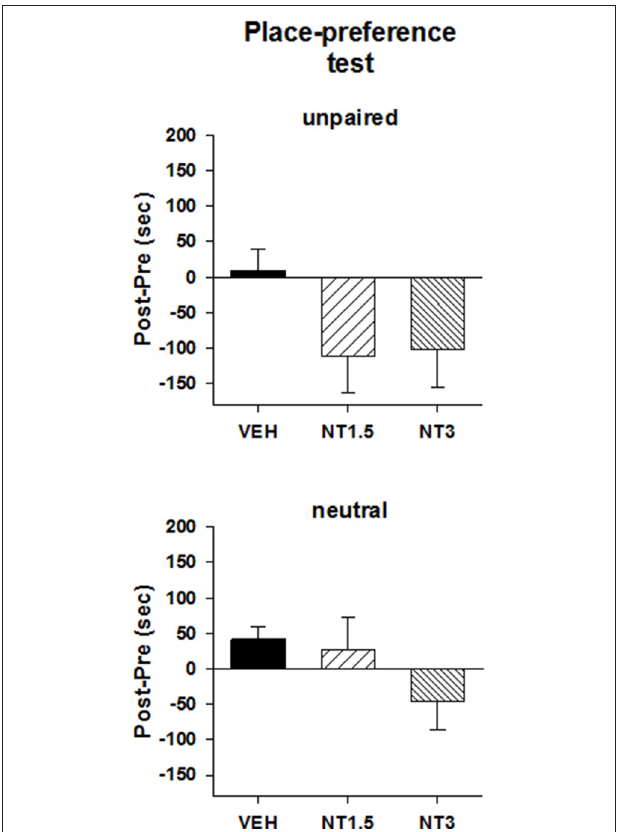
FIGURE 2 | Mean preference score measured on the test day in the unpaired (top panel) and neutral (bottom panel) compartment for the animals that were injected with 1.5nmol (NT1.5, n = 6 ), 3nmol (NT3, n = 13 ) of [D-Tyr 11 ]NT or its vehicle (VEH, n = 15 ). Preference score corresponds to the amount of time (in sec) spent in the unpaired or neutral compartment on the test day minus the time spent at baseline in the same compartment. See text for details.